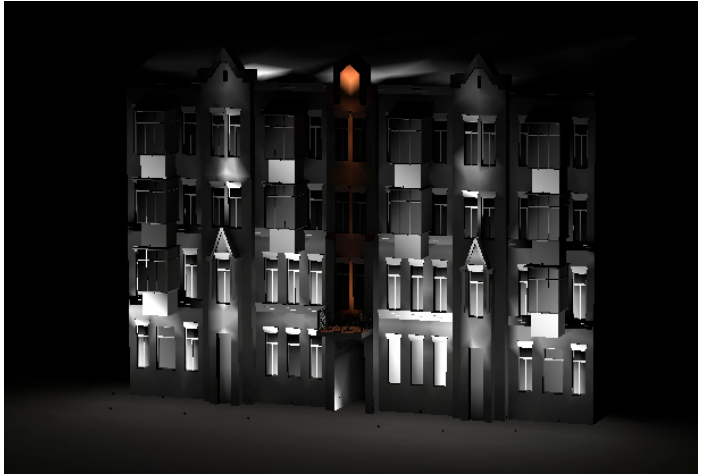
Figure 27. Fast communication of impressionism based on Monet’s painting “Impression”—Scene 2.